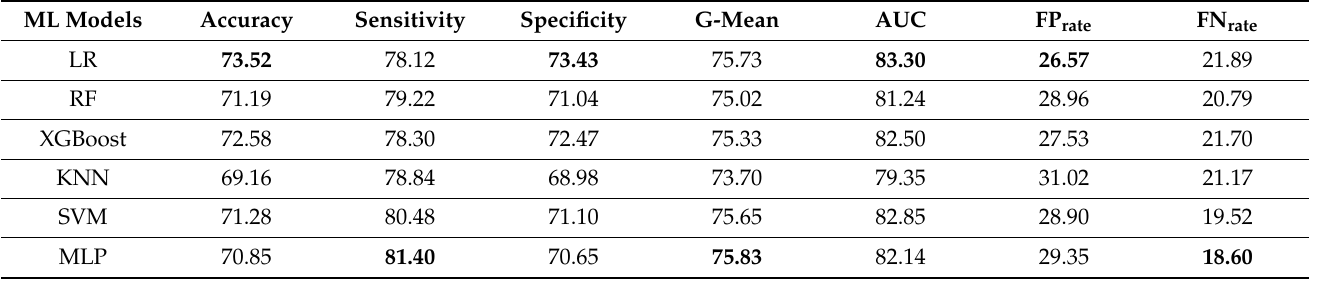
Table 3. Mean results of prediction models (%).